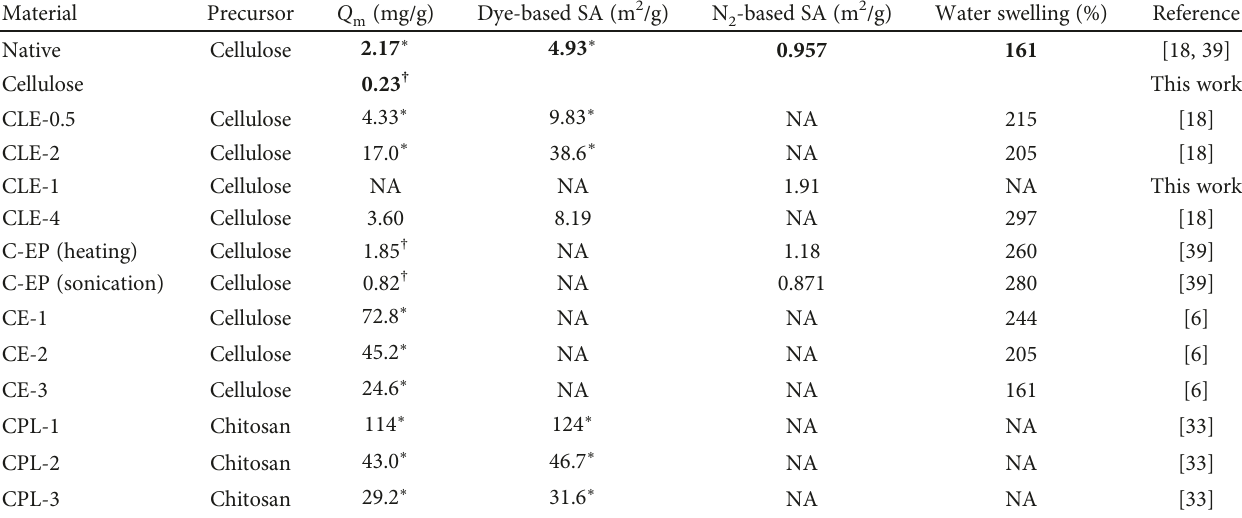
Table 2: E ff ect of cross-linking on the physicochemical properties of biomaterials.